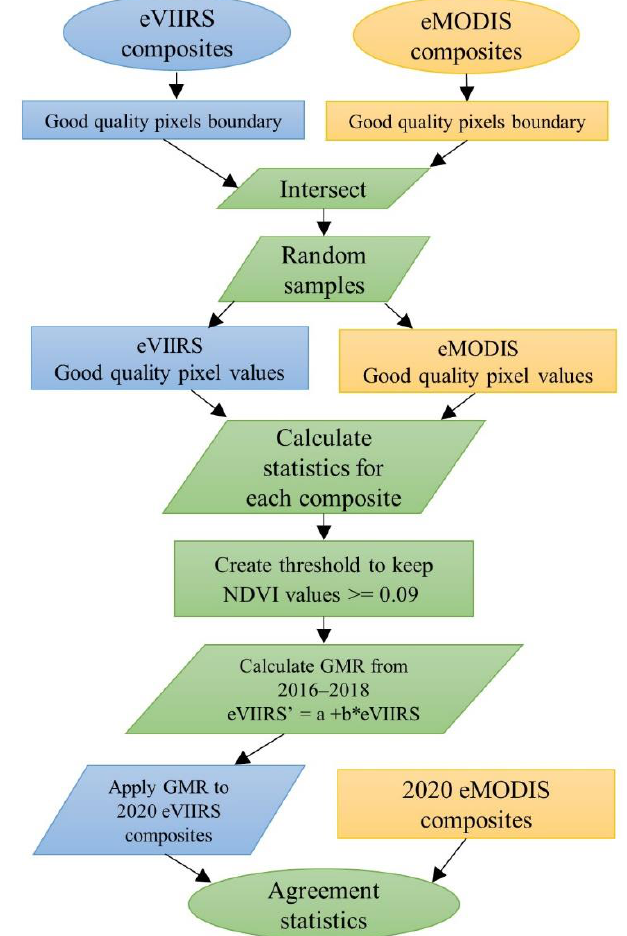
Figure 2. Methods for the geometric mean regression (GMR) transformation from expedited Visible Infrared Imaging Radiometer Suite (eVIIRS) to transformed eVIIRS (eVIIRS’).